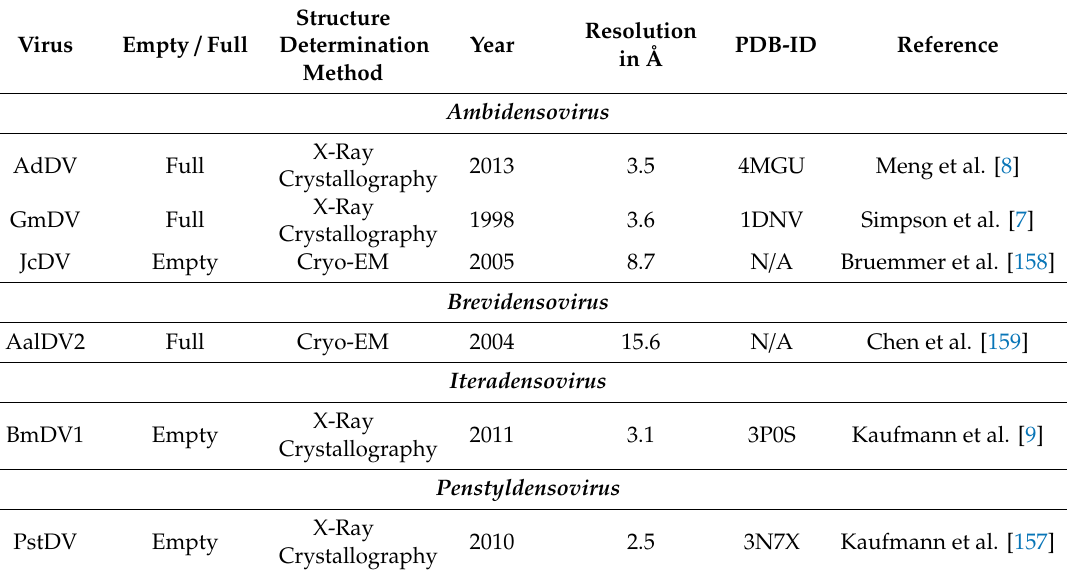
Table 5. Capsid structures of Densovirinae determined to